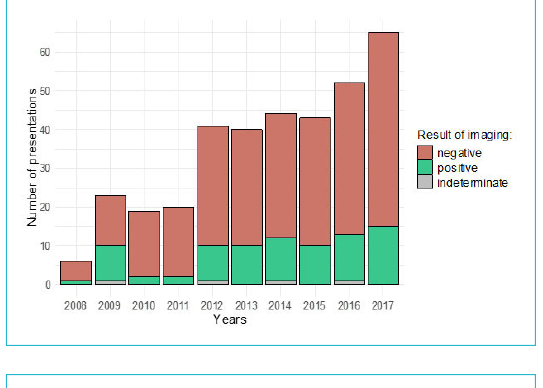
Figure 3: Kaplan-Meier plot of total length of stay (LOS) in hours, stratified by result of imaging, calculated with emergency depart- ment (ED) LOS for outpatients and hospital LOS for inpatients.